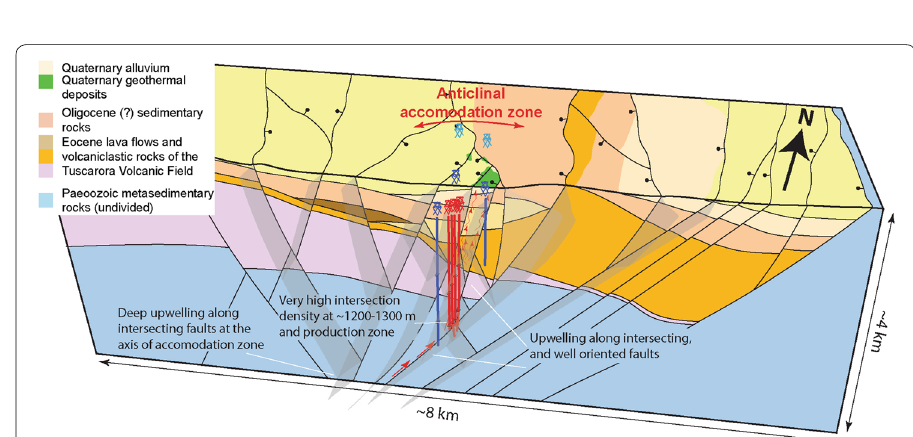
Fig. 13 Conceptual model of fluid upwelling at Tuscarora. Red wells are production wells; dark blue wells are the proximal injection wells; light blue wells are the distal injection wells. Deep upwelling (larger red arrows) occurs from high fault intersection/fault termination density in the axial part of the anticlinal accommodation zone at ~ 3–5 km depth. Fluids upwell along fault intersections, and well-oriented (with respect to the regional stress field), NNE-striking/moderately to steeply dipping fault segments. Another area of relatively high fault intersection/fault termination density occupies the axial part of the accommodation zone at ~ 1200–1300 m depth. The production wells (red) produce fluid from this area. Upwelling continues through the Cenozoic volcanic section, though upwelling through this section is likely diffuse (small red arrows). Fluids outflow at the active hot springs and Quaternary opaline sinter (green). Dark blue injection wells are in communication with the production wells; distal light blue injection wells are not in communication with production wells, as evidenced by tracer tests (Chabora et al.